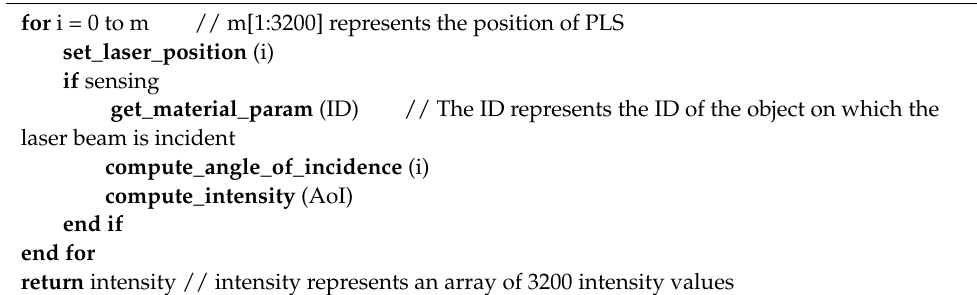
Algorithm 1. Evaluation of the reflected laser ray (beam)